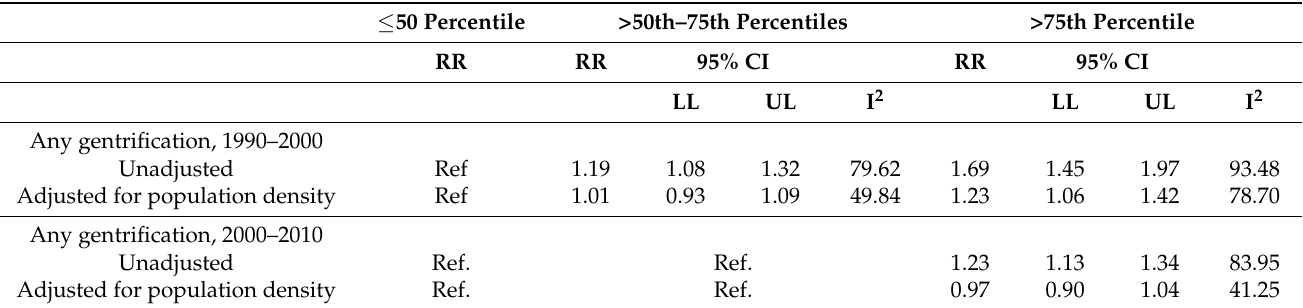
Table 2. Relative Risk (RR) and 95% Confidence Interval (CI) estimates of association between percentage greenspace and any gentrification, from 1990–2000 or 2000–2010 1,2